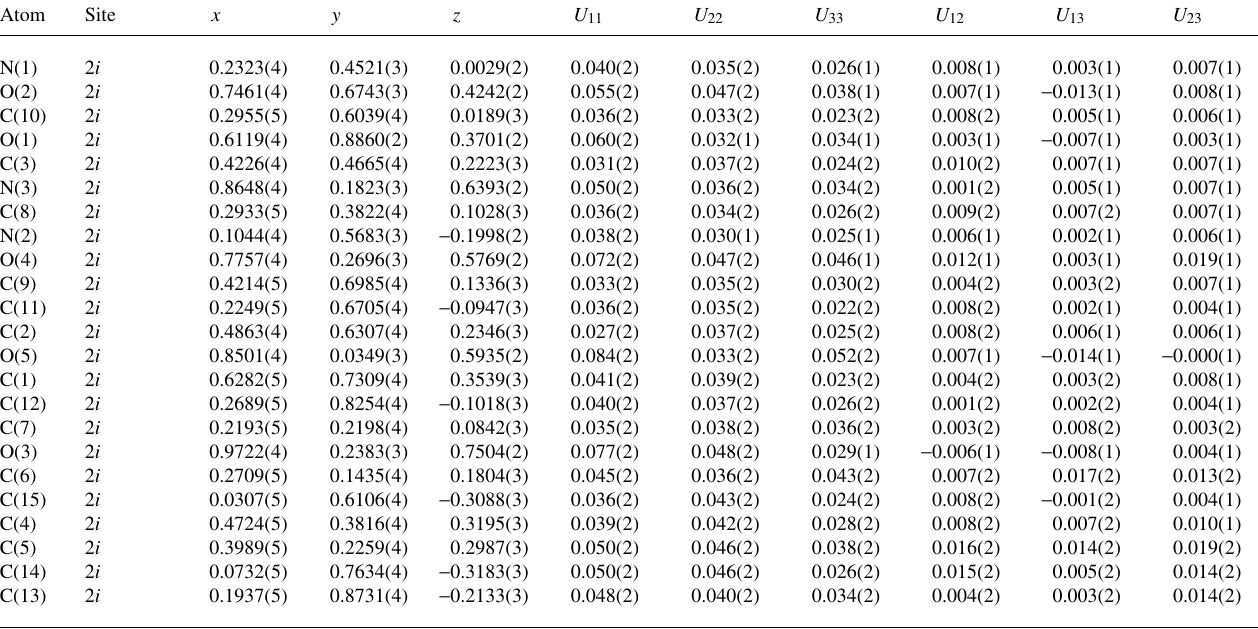
Table 3. Atomic coordinates and displacement parameters (in Å 2 )